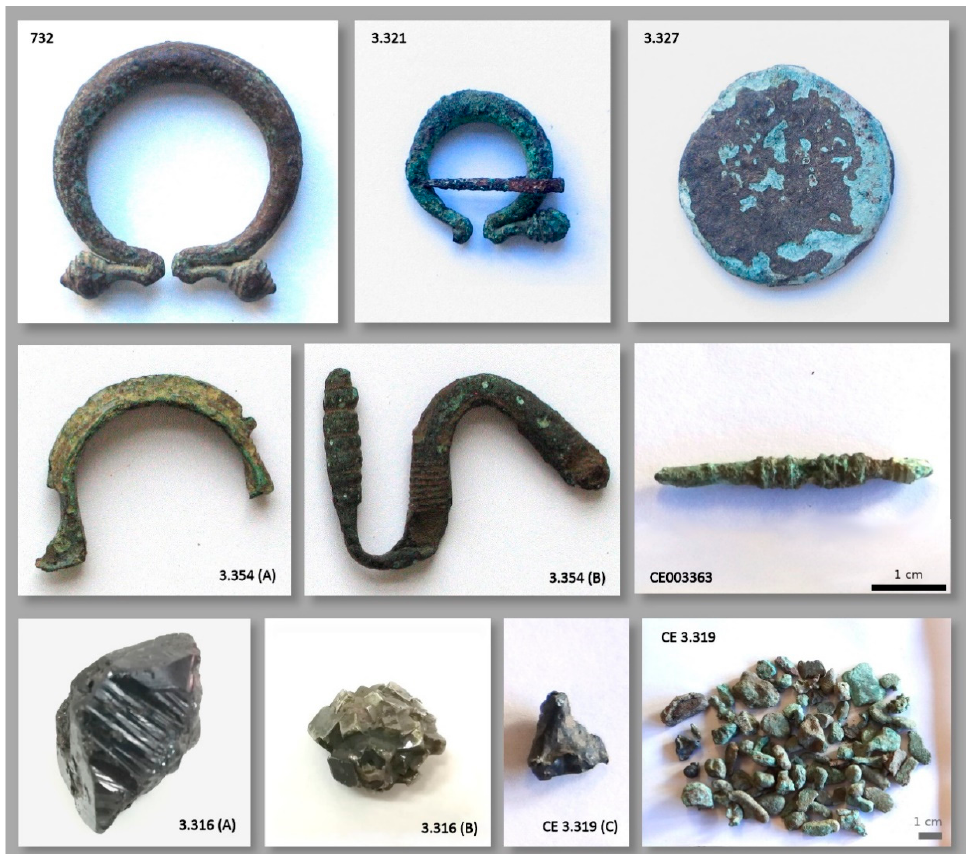
Figure 6. Examples of some of the artefacts analyzed by pXRF from Outeiro de Baltar hillfort at the Museo Arqueolóxico Provincial de Ourense (Galicia, Spain), which include fibulae (732; 3.321; 3.354 ( A ); 3.354 ( B )), a coin (3.327), a decorated pin (CE003363), a cassiterite crystal (3.316 ( A )), pyrite crystals (3.316 ( B )), a tin slag (CE 3.319 ( C )) and metal scrap nodules (CE 3.319). Black scale applies to all artefacts’ photographs, and gray scale (bottom right) only applies to the CE 3.319 photograph.